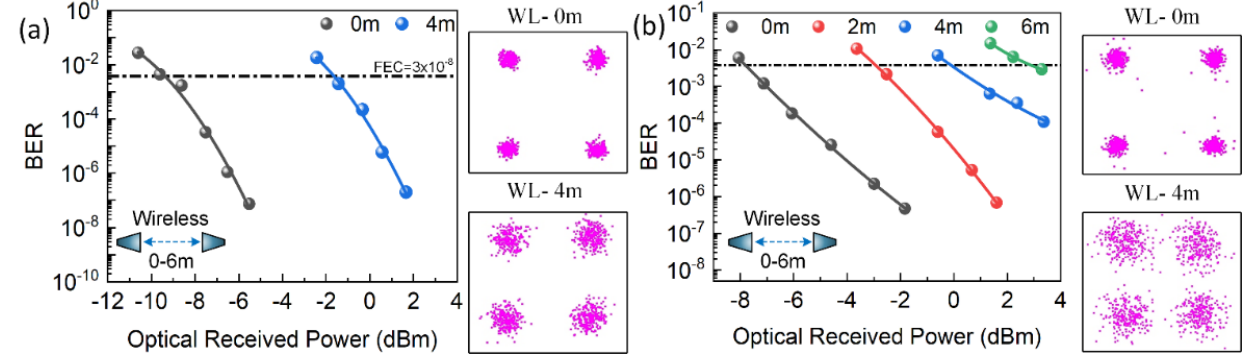
Figure 4. Bit error rate (BER) versus optical received power of the commercial laser and dual-wavelength laser (CL-DWL) source at 28 GHz ( a ) and the QD-DWL source at 28 GHz ( b ) for the WL channel with various link lengths. The respective insets show the received QPSK constellation at a ~0 dBm received optical power for the 0-m (top) and 4-m (bottom) WL link lengths. Table 1. Measured optical received power levels required for error-free transmissions in various channels for 28- and 30-GHz MMW systems.